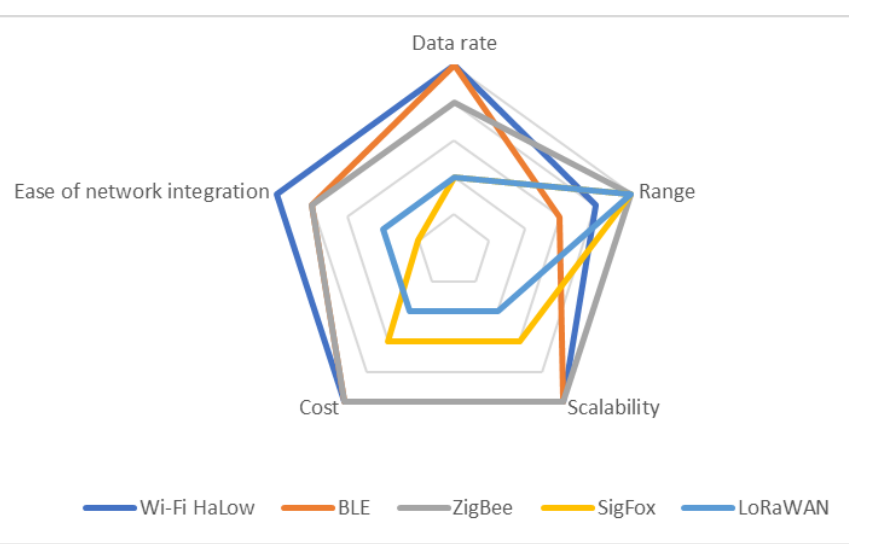
Figure 1. Comparison of the performance of each communication protocol in key parameters. Data obtained in Ref [11] 2021, Wi-Fi CERTIFIED HaLow™ .